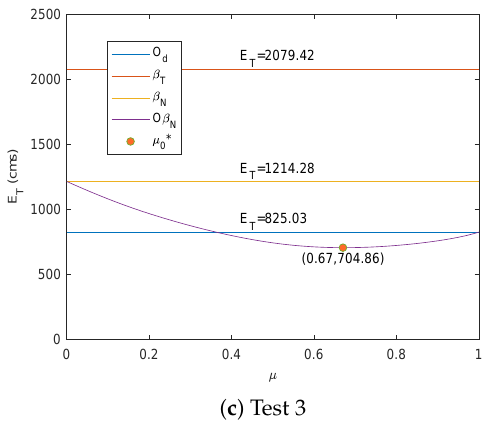
Figure 7. Optimal parameter of µ from Proposition 1 for three